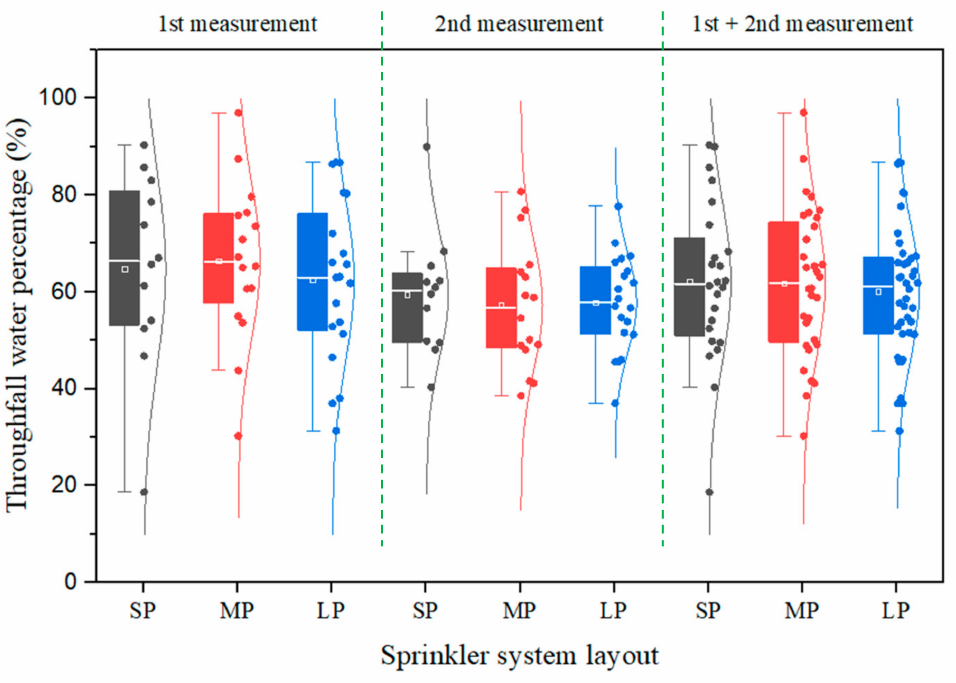
Figure 6. Distribution of throughfall water percentage under the three sprinkler system layouts in the two measurements.